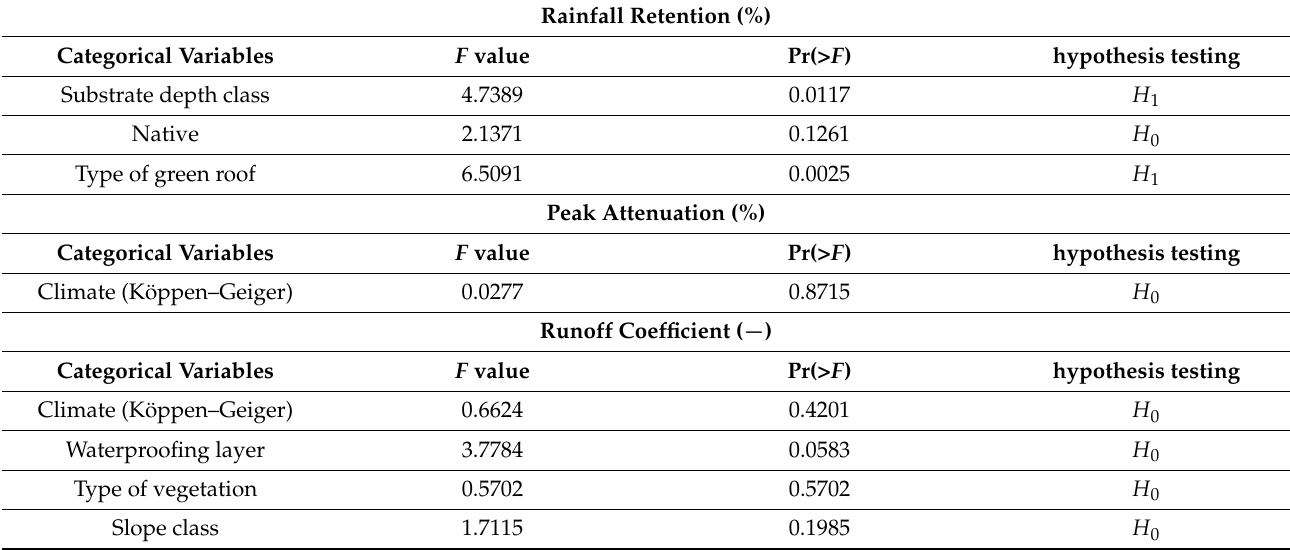
Table A5. Levene’s test results for rainfall retention (%), peak attenuation (%), and runoff coefficient ( −